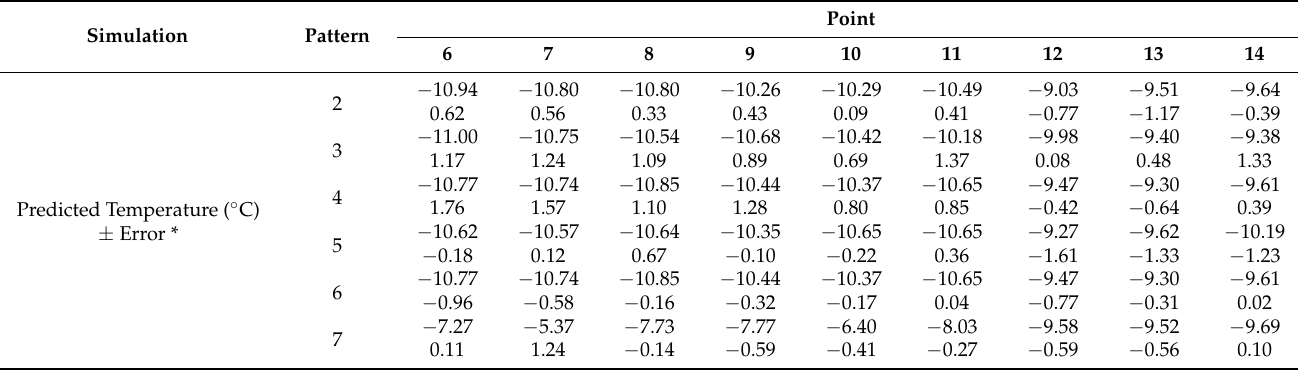
Table 6. The simulated lowest temperature values in the boxes.